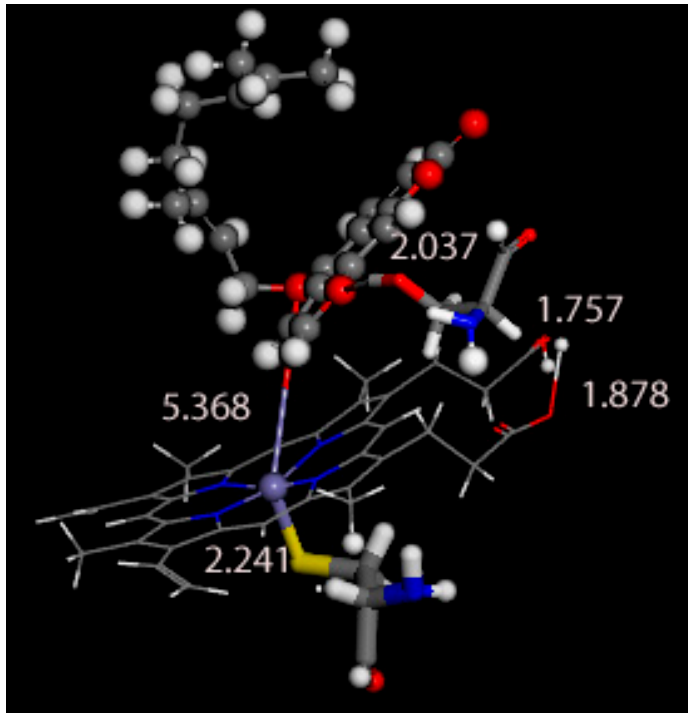
Figure 11. ( Berg6 ). Result of DFT geometry minimization of docked Berg pose 6. All fixed amino acids are omitted for clarity. Arg − 105 is only partially shown for clarity; only its 2 H atoms engaged